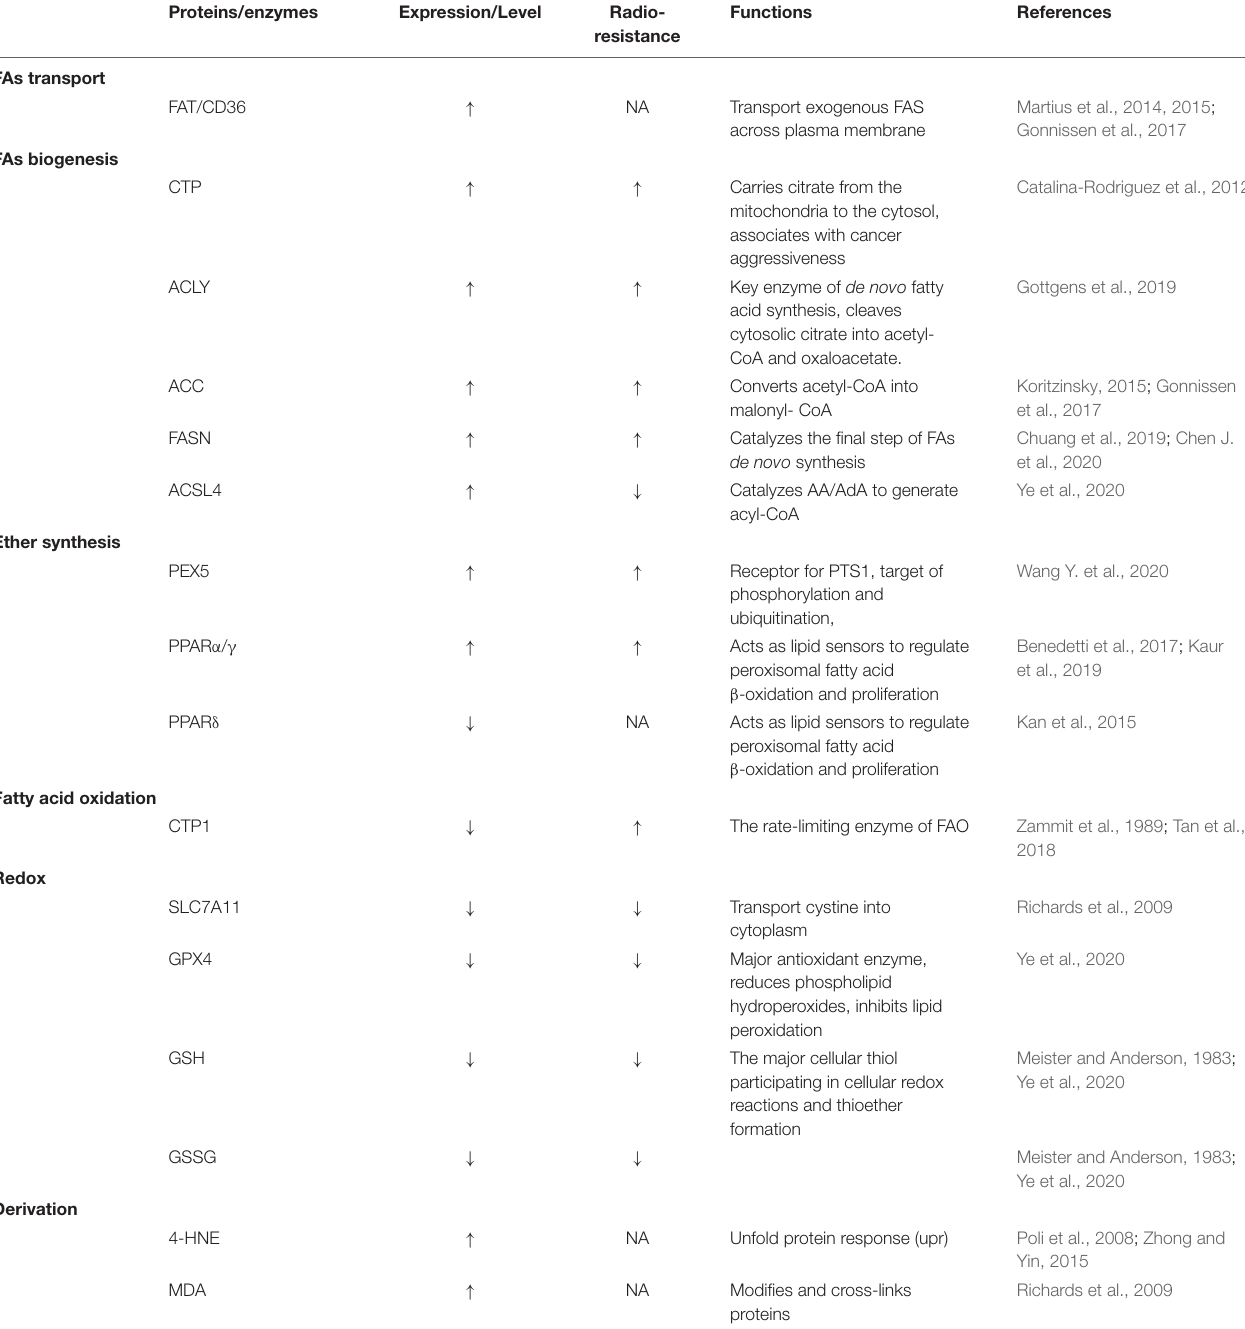
TABLE 1 | Proteins or enzymes influenced by ionizing radiation in fatty acids metabolism and ferroptosis.